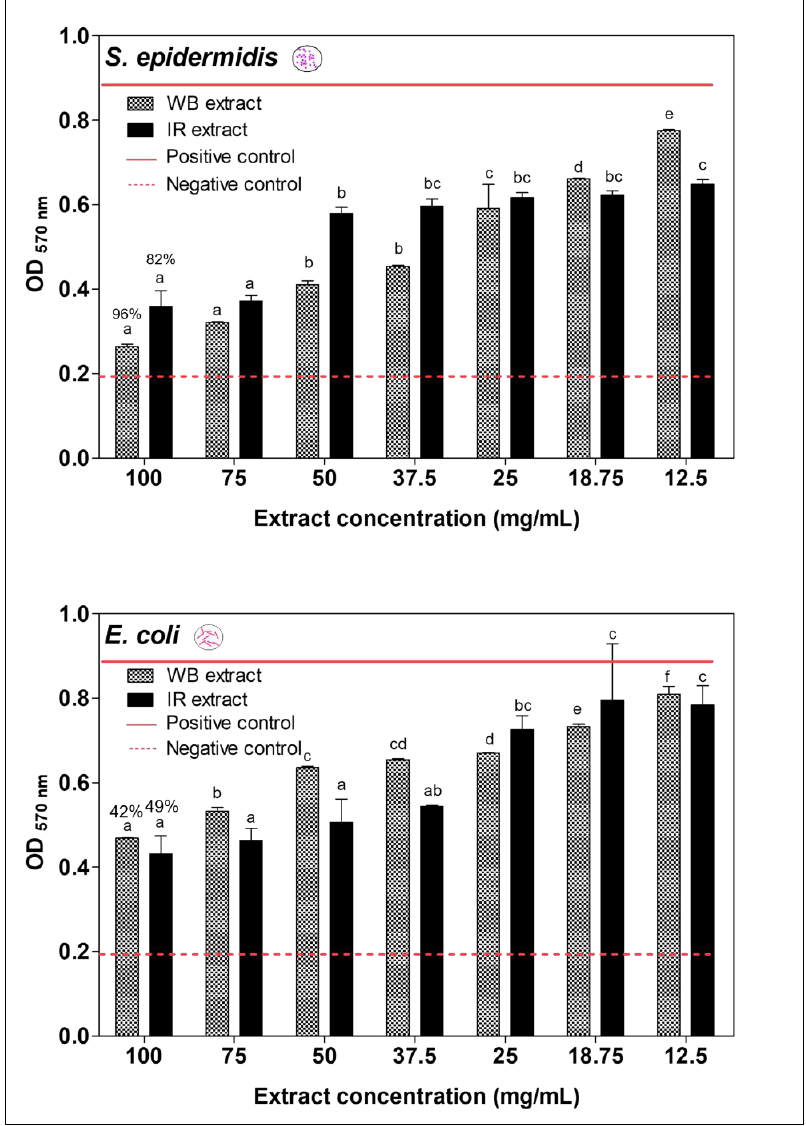
Figure 5. Preventing antibiofilm activity of different concentrations of Eryngium creticum leaf extracts on Staphylococcus epidermidis and Escherichia coli strains. Red continuous line corresponds to OD 0.9, red dashed line corresponds to OD 0.2. Different letters (a, b, c, d, e, and f) on the bars indicate significant statistical difference ( p < 0.05).